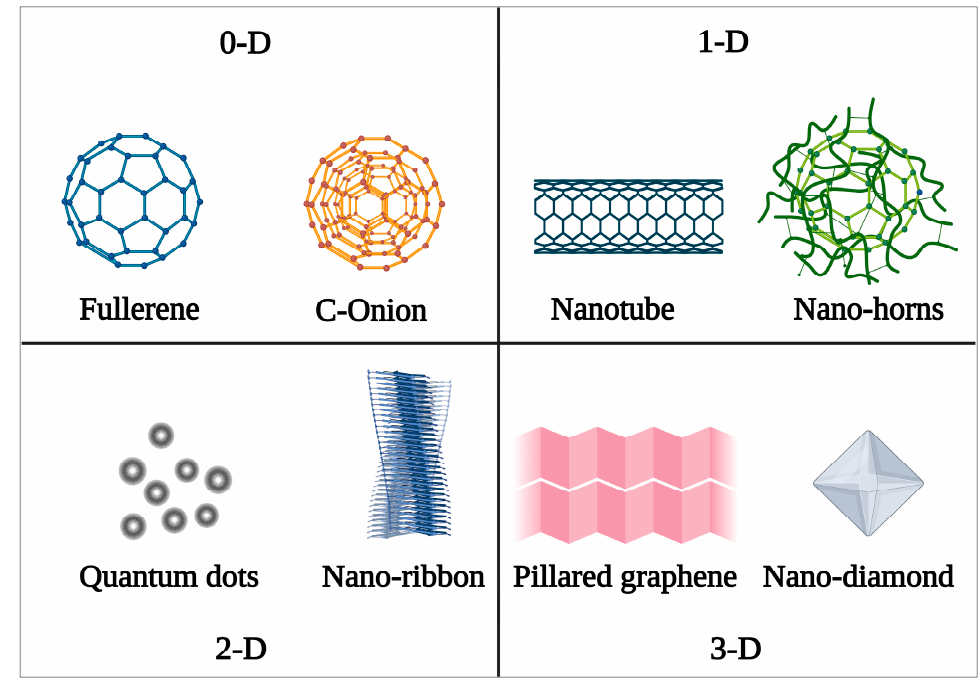
Figure 2. Various architectural categories of carbon nanostructures.